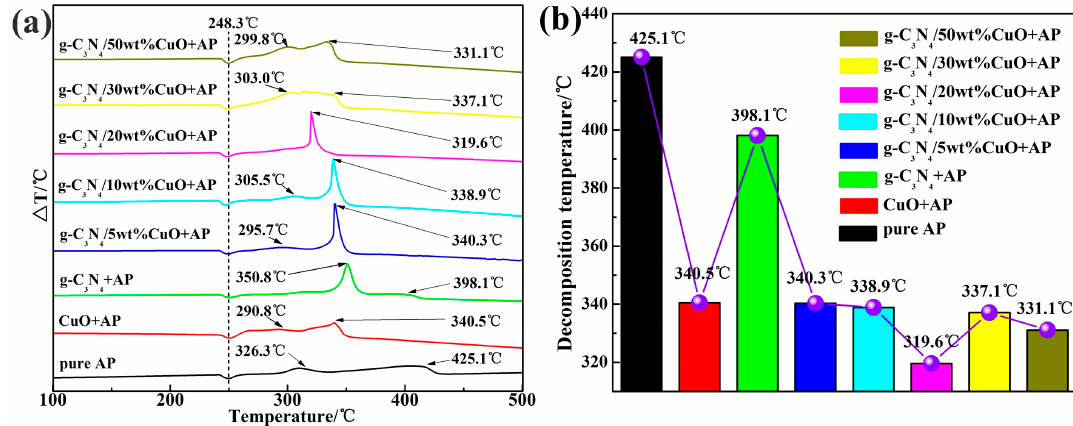
Figure 5. ( a ) Differential thermal analysis (DTA) curves of ammonium perchlorate (AP) in the absence and presence of a catalyst; ( b ) histogram of the corresponding high decomposition temperature.